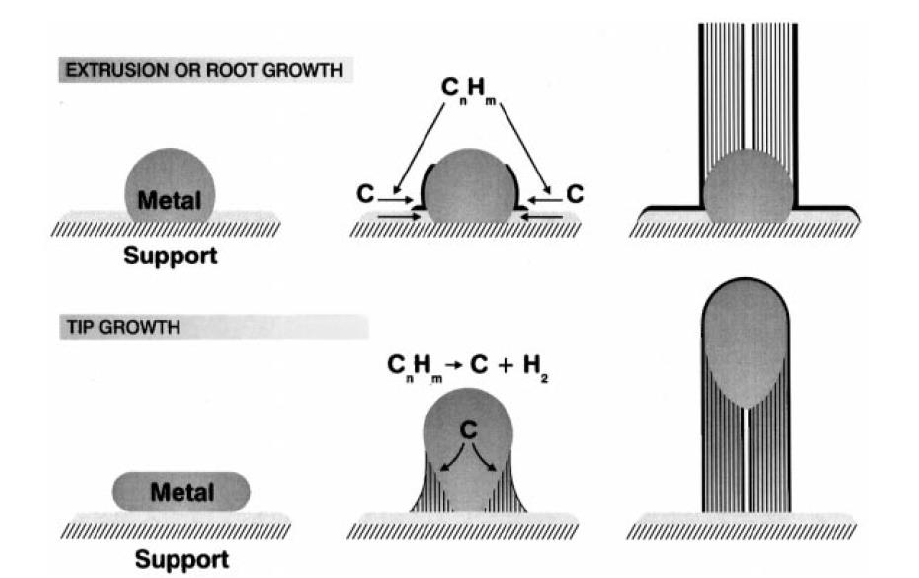
Figure 1. Schematics of root-growth and tip-growth mechanisms for carbon filament growth (Sinnott et al.,